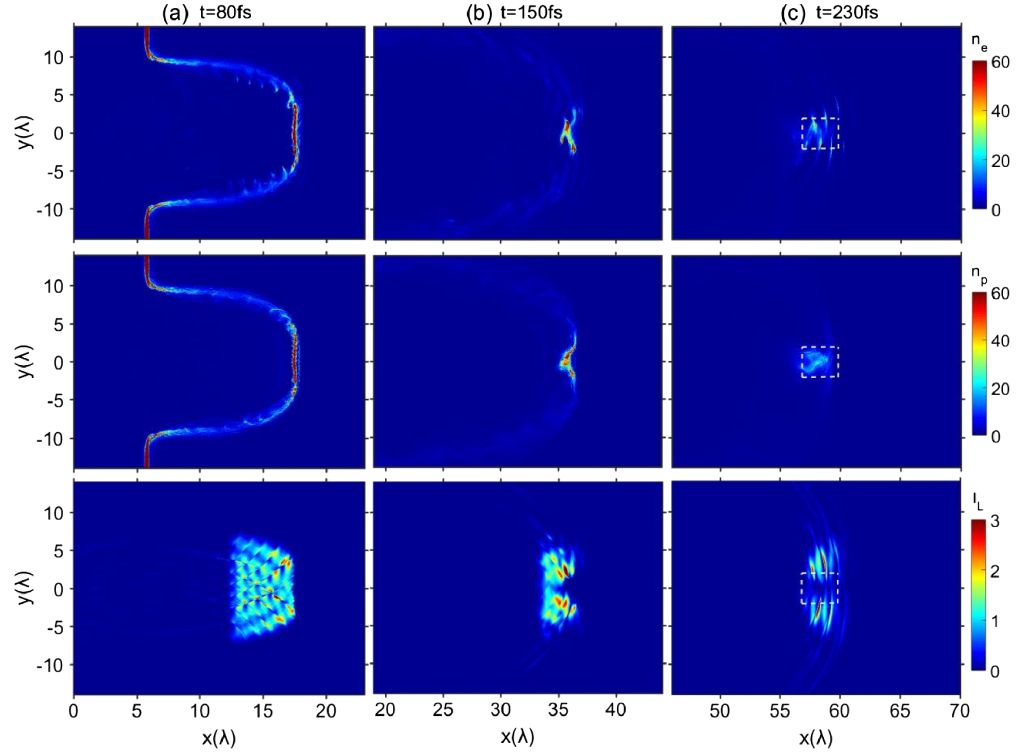
FIG. 2. Snapshots of electron density (normalized by n cr ), proton density (normalized by n cr ), and laser intensity (normalized by E 2 0 ) for a common RPA at three moments: t ¼ 80 fs (a), t ¼ 150 fs (b), and t ¼ 230 fs (c). The dashed line boxes indicate the position of particle